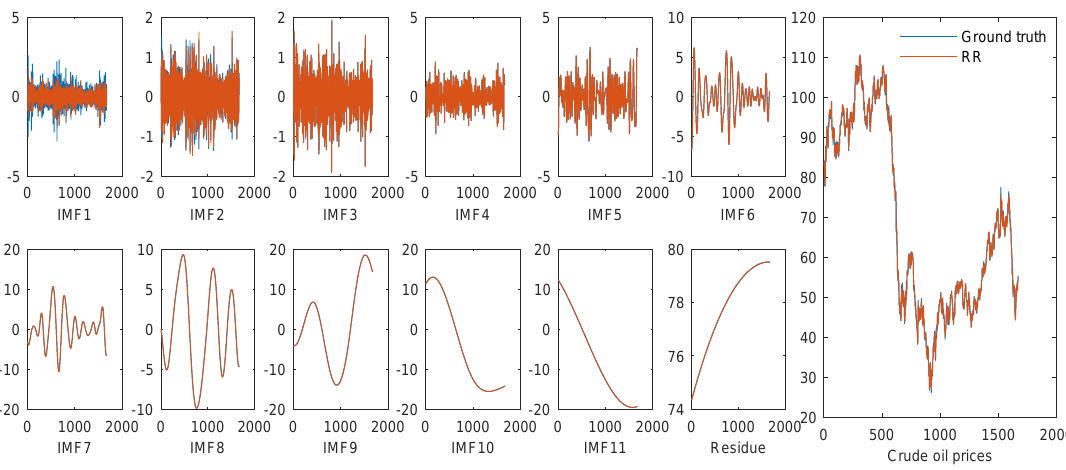
Figure 6. The individual and final forecasting results by